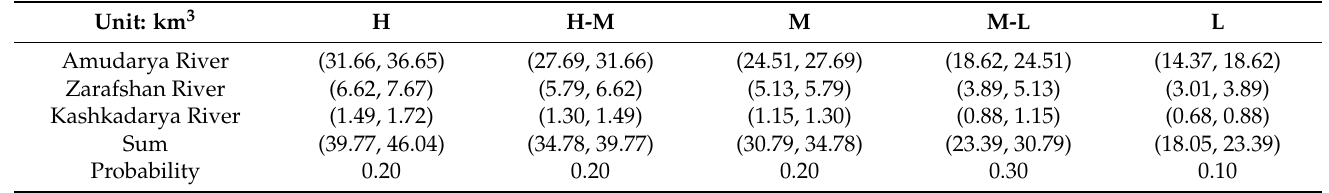
Table 4. Five probability intervals of water supply in study